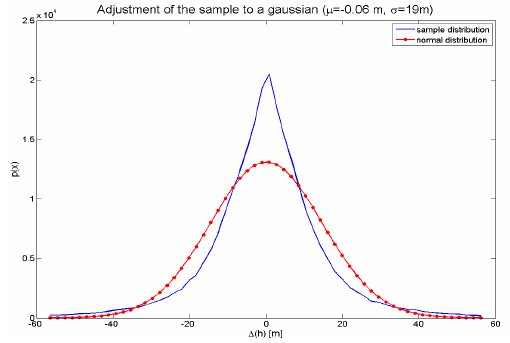
Figure 2. Adjustment of the height differences